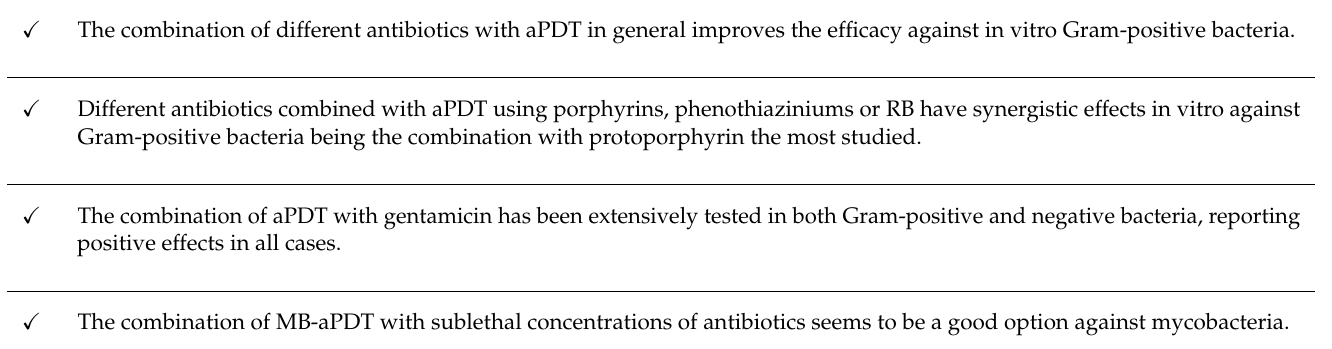
Table 7. The highlight combinations and the best treatment protocols supported by the existing evidence of in vitro studies on combined aPDT therapies against SSTI-causing